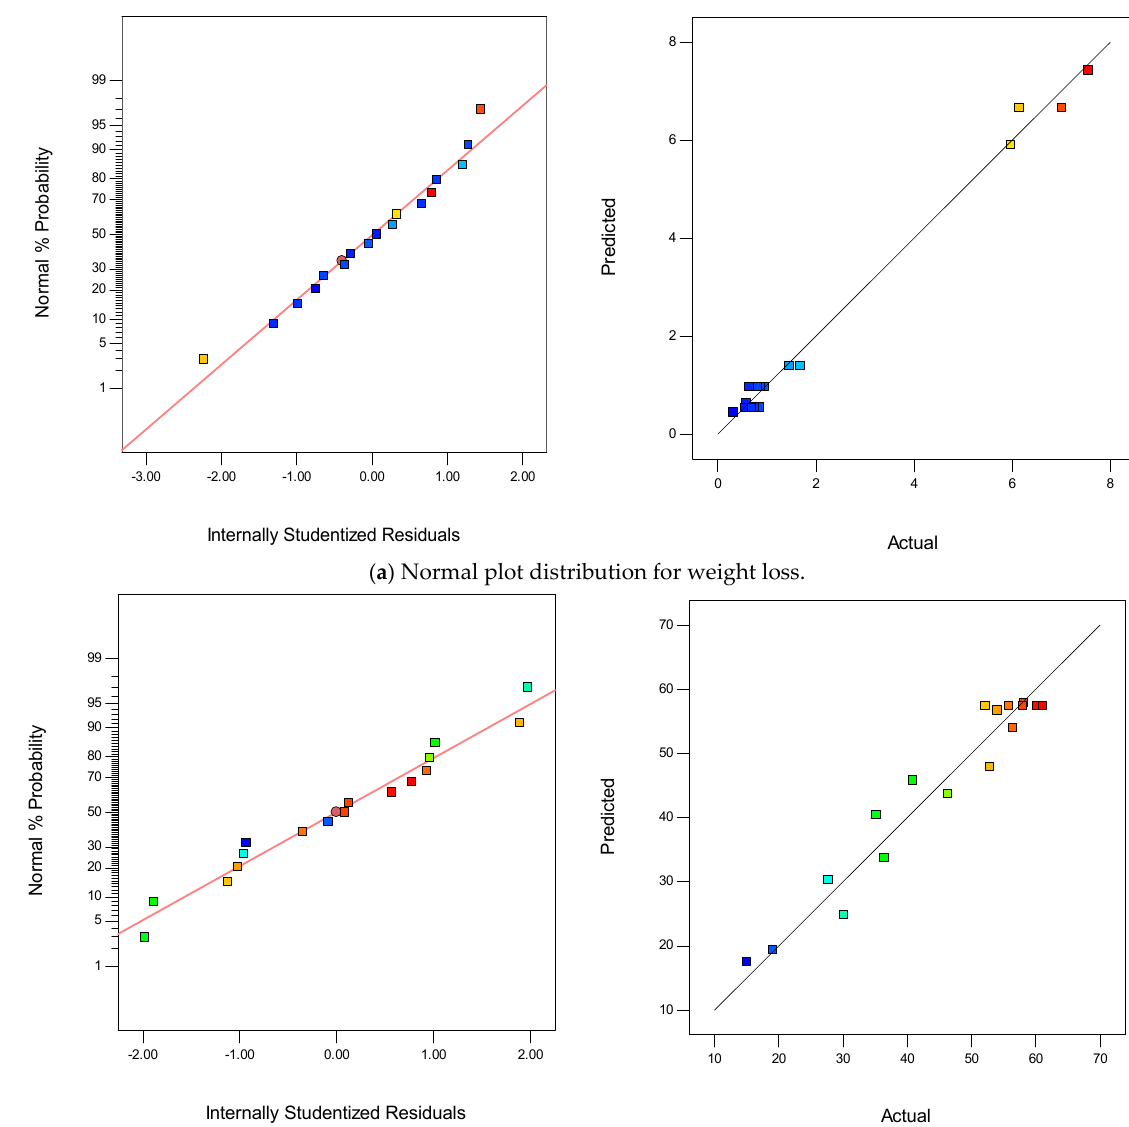
( b ) Normal plot distribution for compressive strength. Figure 4. Cont